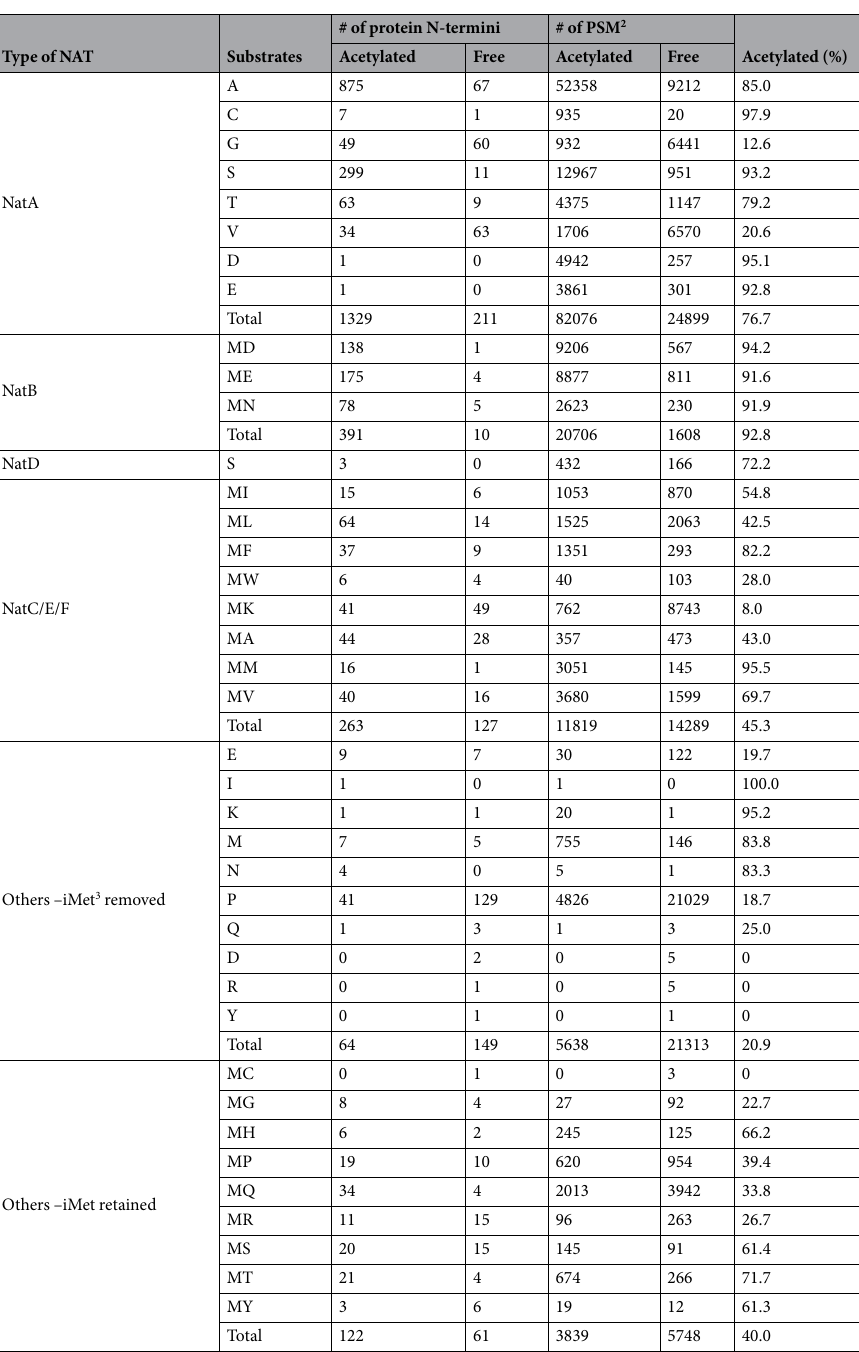
Table 1. Classification of dbTIS 1 protein N-termini according to the substrate type of N- α -terminal acetyltransferases in human (NATs). 1 dbTIS: UniProtKB-annotated translation initiation sites, 2 PSM: Peptide spectrum match, 3 iMet: initiator